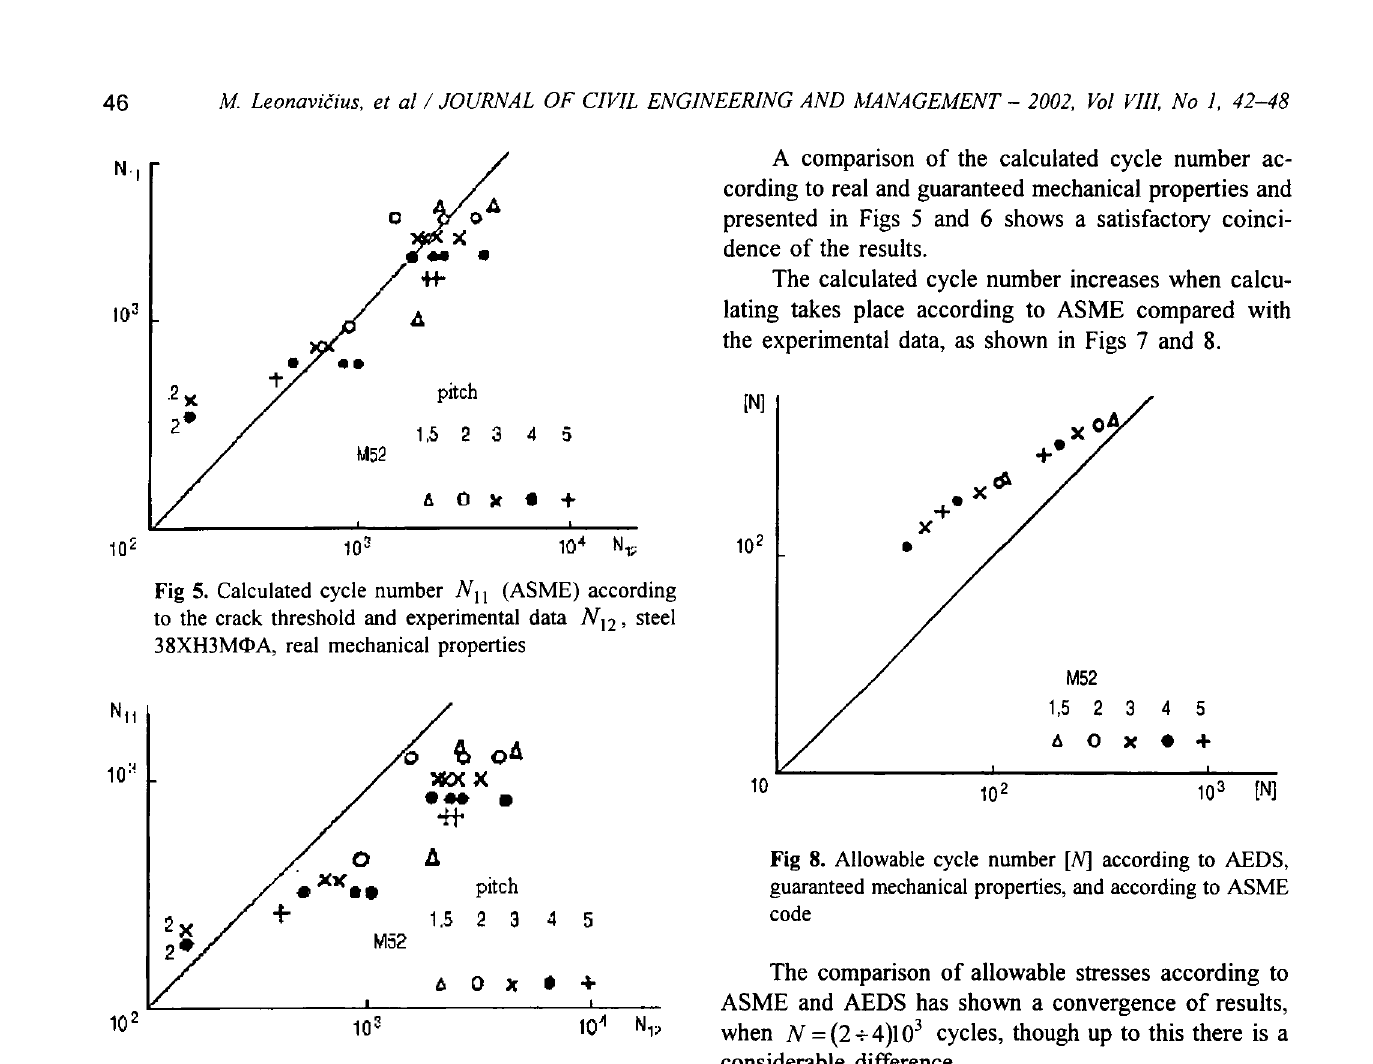
Fig 6. Calculated cycle number N to the crack threshold and experimental data N 38XH3M<l>A, guaranteed mechanical properties